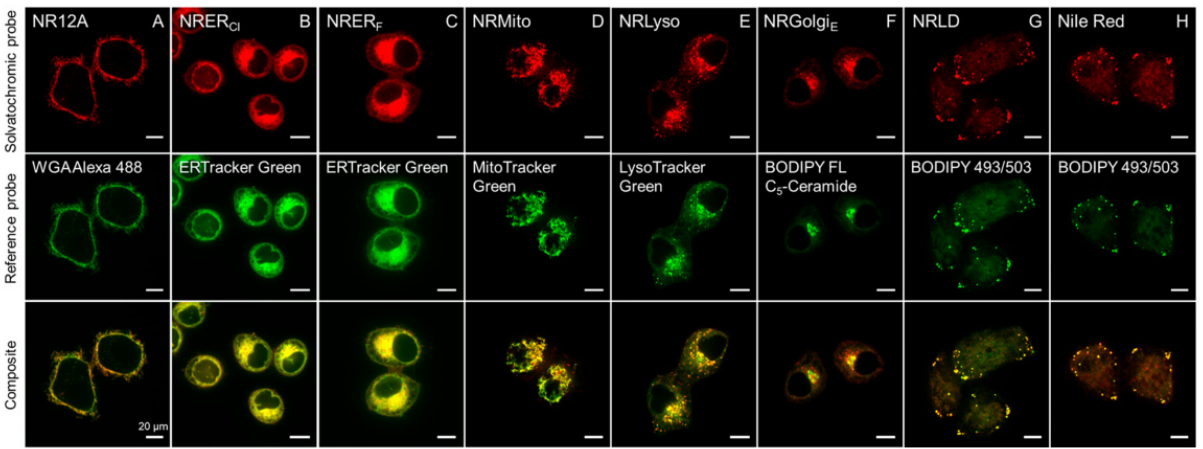
Figure 28. Confocal microscopy colocalization images of live KB cells stained with probes 32 and commercial organelle probes. Row 1 : Probes 34 (NR12A, NRMito, NRLyso, NRLD, NRER Cl , NRER F , NRGolgi E ) fluorescence under a red channel, row 2 : commercial organelle probes under a green channel, and row 3 : merged images. Adapted from [72].